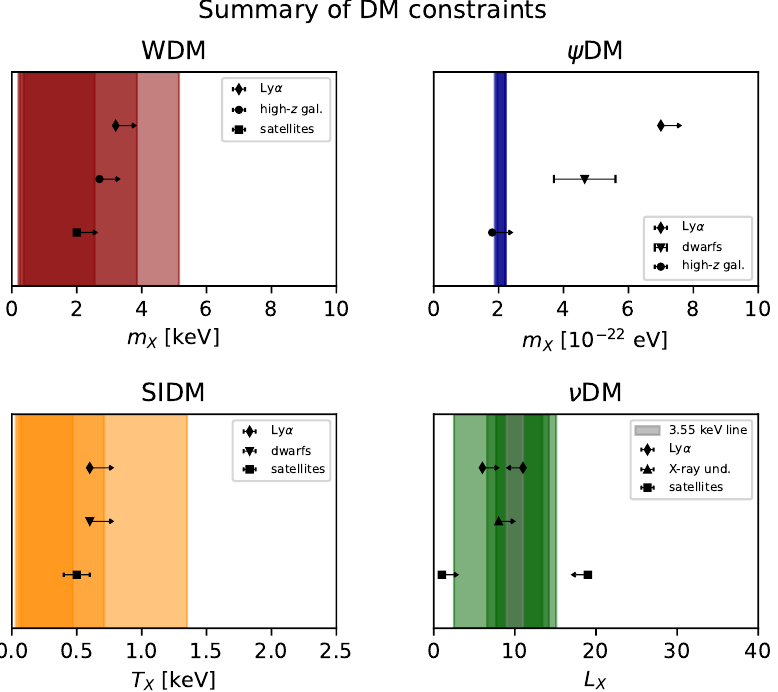
Figure 6. Summary of the astroparticle constraints in different DM scenarios. The colored shaded areas illustrate the constraints from this work for confidence intervals of 2 σ , 3 σ , and 5 σ (from darker to lighter shades). The black points show the literature constraints from independent observations: for WDM (top left panel) from [46] (diamond), [50] (circle) and [68] (square); for ψ DM (top right panel) from [47] (diamond and circle) and [127] (inverted triangle); for SIDM (bottom left panel) from [46] (diamond), [33] (inverted triangle) and [35] (square); for ν DM (bottom right panel) from [128] (grey shaded area), [46] (diamond), [129] (triangle) and [130]